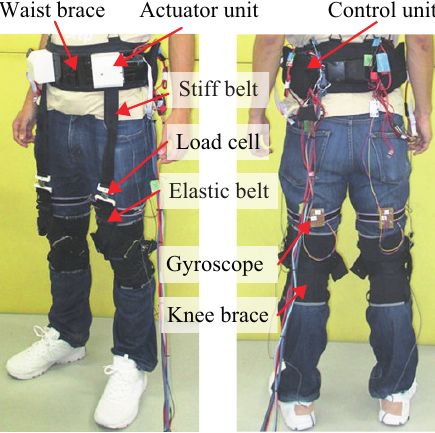
Figure 1. Entire design of a soft wearable robotic suit for hip flexion.